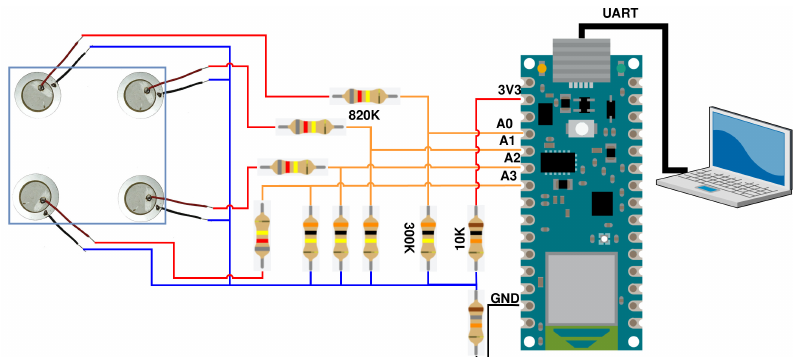
Figure 6. PZT modules connected to Arduino NANO 33